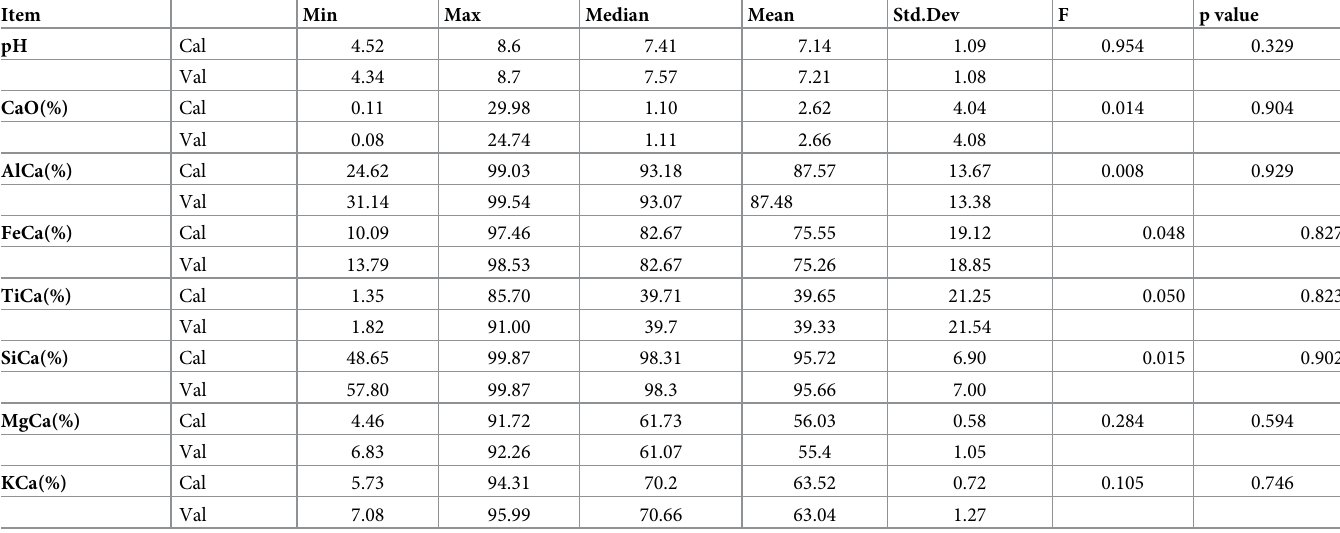
Table 4. Differences in soil pH and geochemical indices between calibration and validation sets (N = 877 and 286 for calibration (Cal) and validation (Val) sets, respectively.).